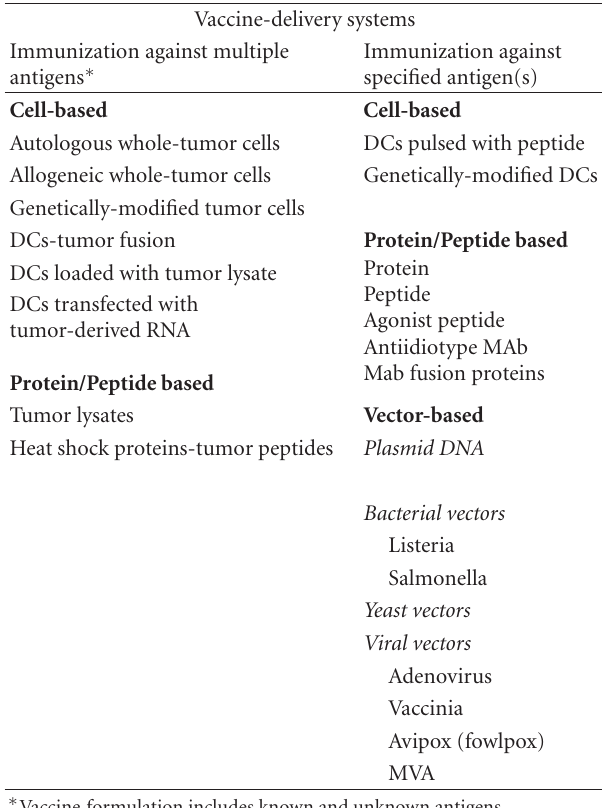
Table 1: Vaccine-delivery